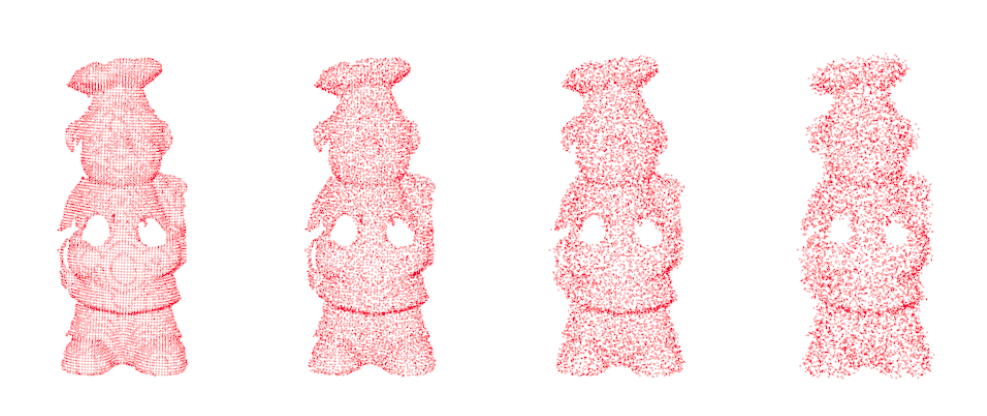
Figure 7. Different Gaussian noise levels are on Chef, the standard deviations from left to right are 0, 0.5, 1, 2, respectively.